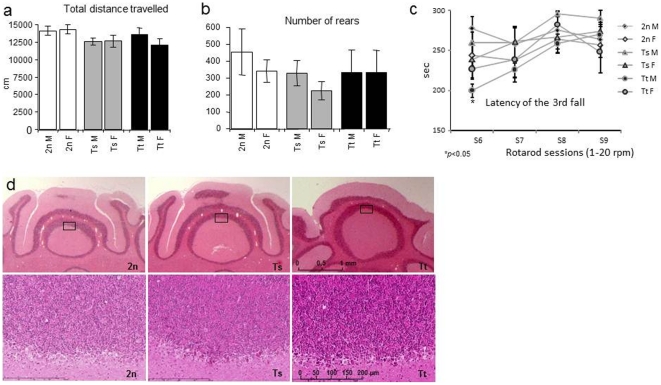
Locomotor activity of 2n, Ts and Tt mice and histological analysis of the cerebellum.(a) and (b) Mean ± SEM for the total distance travelled and the number of rears during the 30 min session in the open field. (c) Mean ± SEM for the latency to fall from the ratorod. (d) Hematoxylin/eosin-stained coronal sections in through the cerebellum of 6 month-old 2n, Ts and Tt mice (×1,25 and ×40 magnifications) showing similar granular cell layers for the different mice. The position of the enlarged zone in the higher magnifications is shown by the boxes in the top panel.